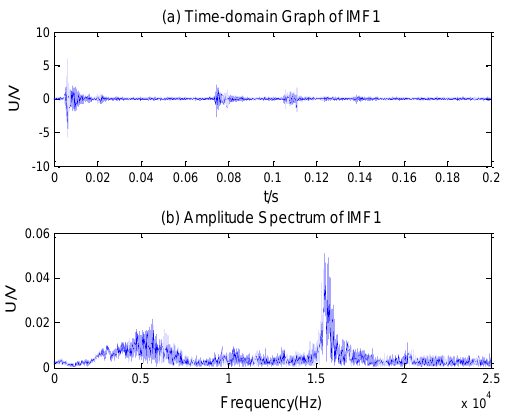
Figure 9. Ensemble empirical mode decomposition (EEMD) decomposition result. Table 3. Comparison of three algorithms.